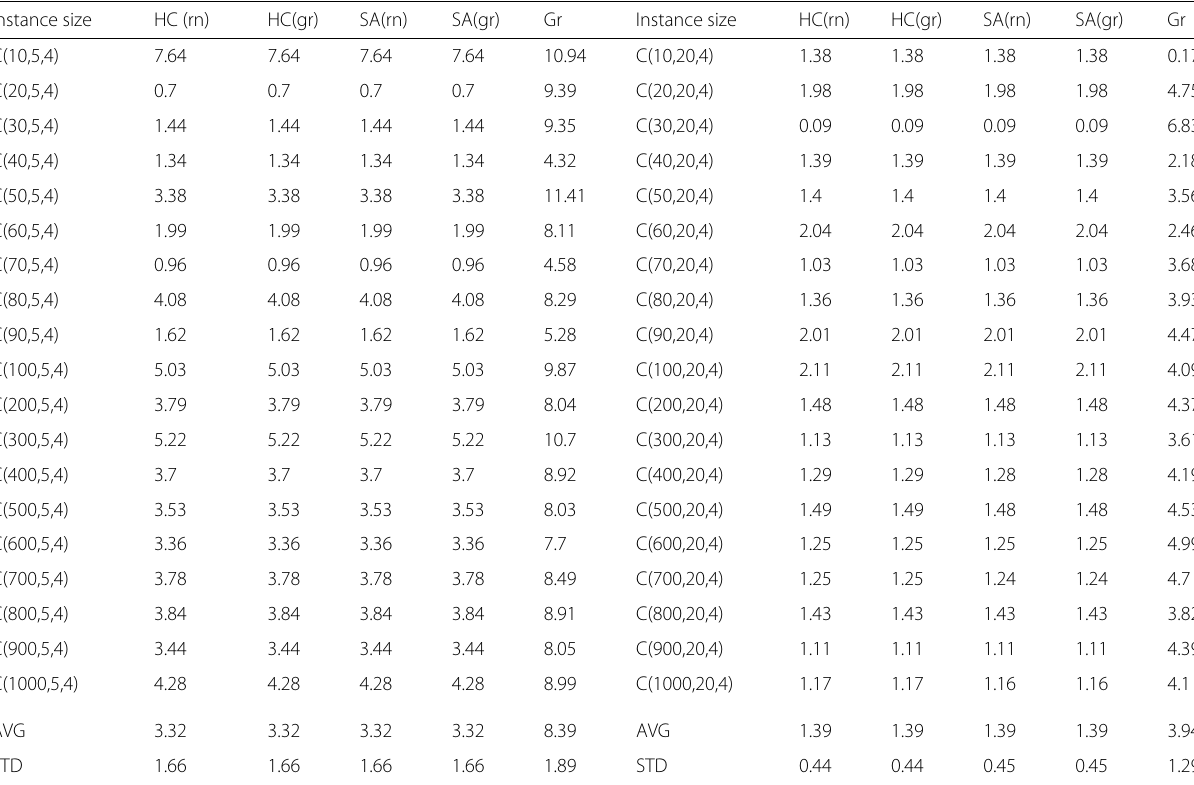
Table 7 Percent deviation from the optimal solution on different instance sizes(l=5;